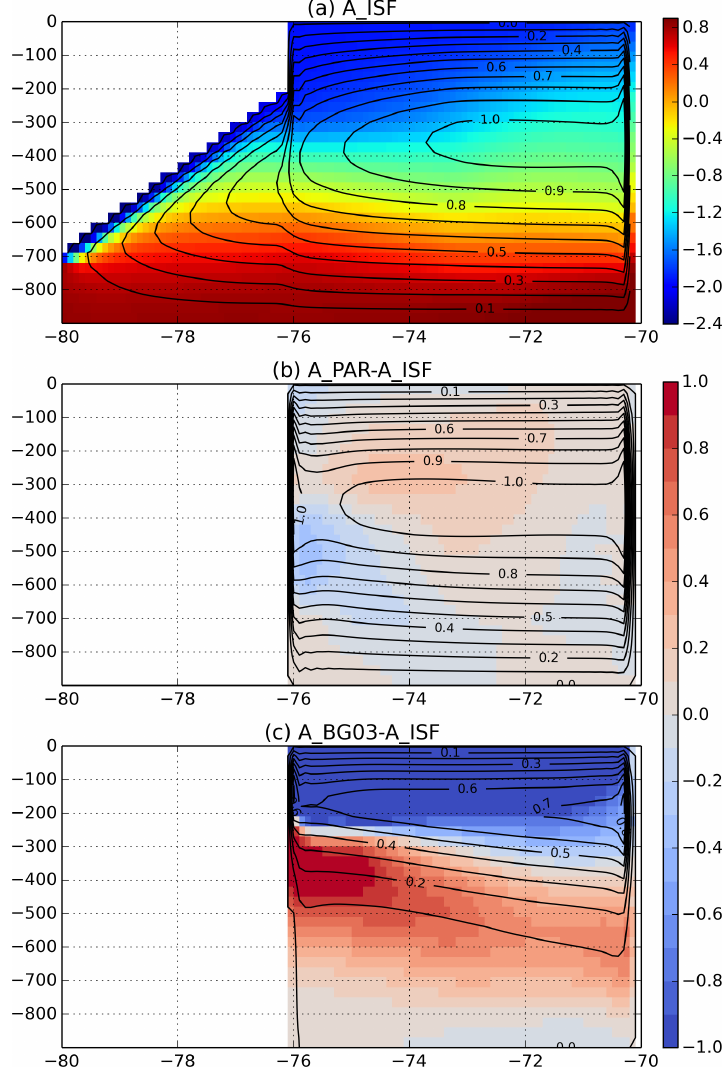
Figure 5. (a) Zonal mean temperature ( ◦ C) after 30years of the run; in contour, the meridional overturning stream function (Meridional Overturning Circulation, MOC) in the A_ISF experiment. (b) Mean temperature difference ( ◦ C) with respect to A_ISF experiment (A_PAR- A_ISF); in contour, the MOC in the A_PAR experiment. (c) as (b) but for A_BG03.